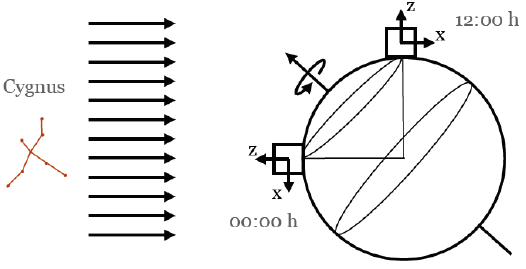
Figure 12: Spin axis of Earth with respect to the WIMP “wind” generated by the motion of the Earth through the Galaxy. Figure excerpted from Ref. [ 21 ]